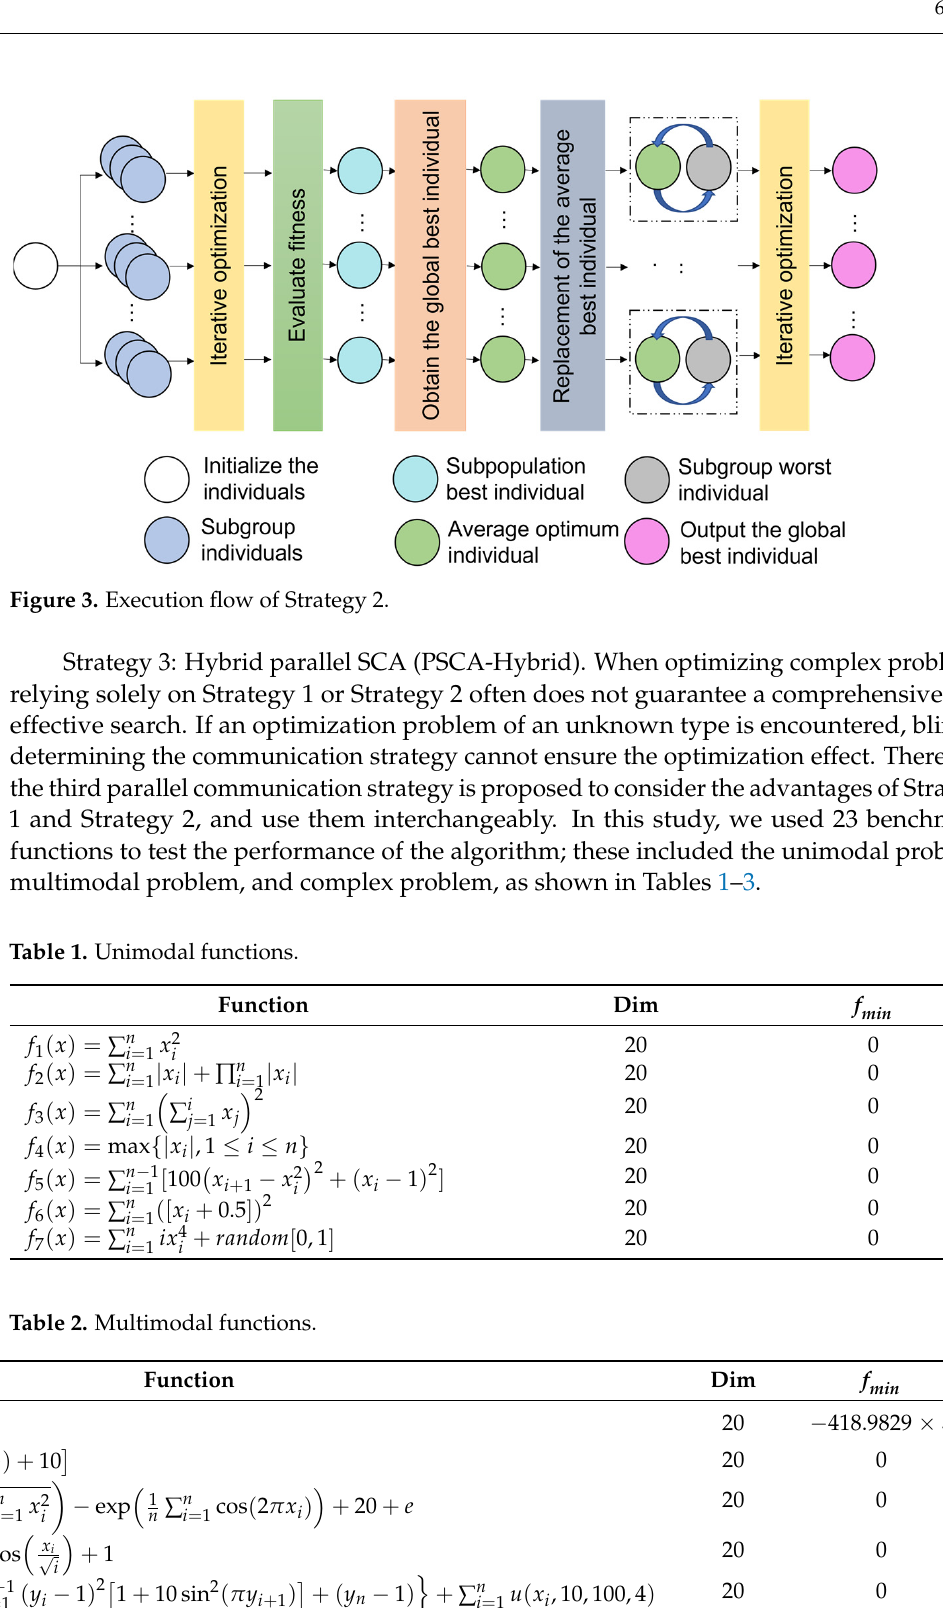
6 of 21 Figure 2. Execution flow of Strategy 1. Strategy 2: Parallel SCA based on optimal mean replacement (PSCA- Mean). The ex- ecution flow is shown in Figure 3. There are several extrema of the multimodal problem and consider jump out of the local optimum. In Strategy 1, the search method is domi- nated by the global optimum, and it will easily fall into the local optimum when solving